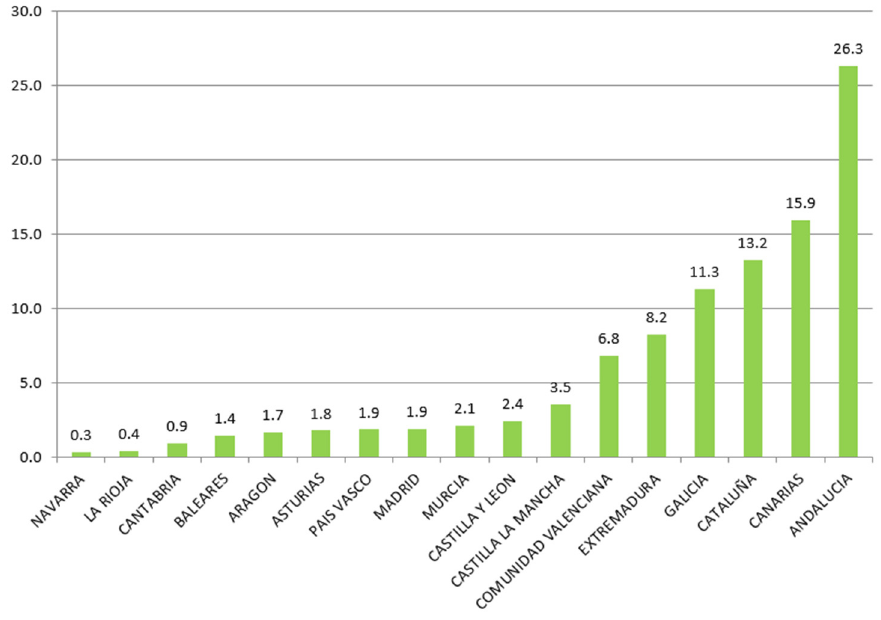
Figure 1. Distribution of ERDF Funds by Region. Period 2014–2019 (%). Source: European Commission and own calculations.